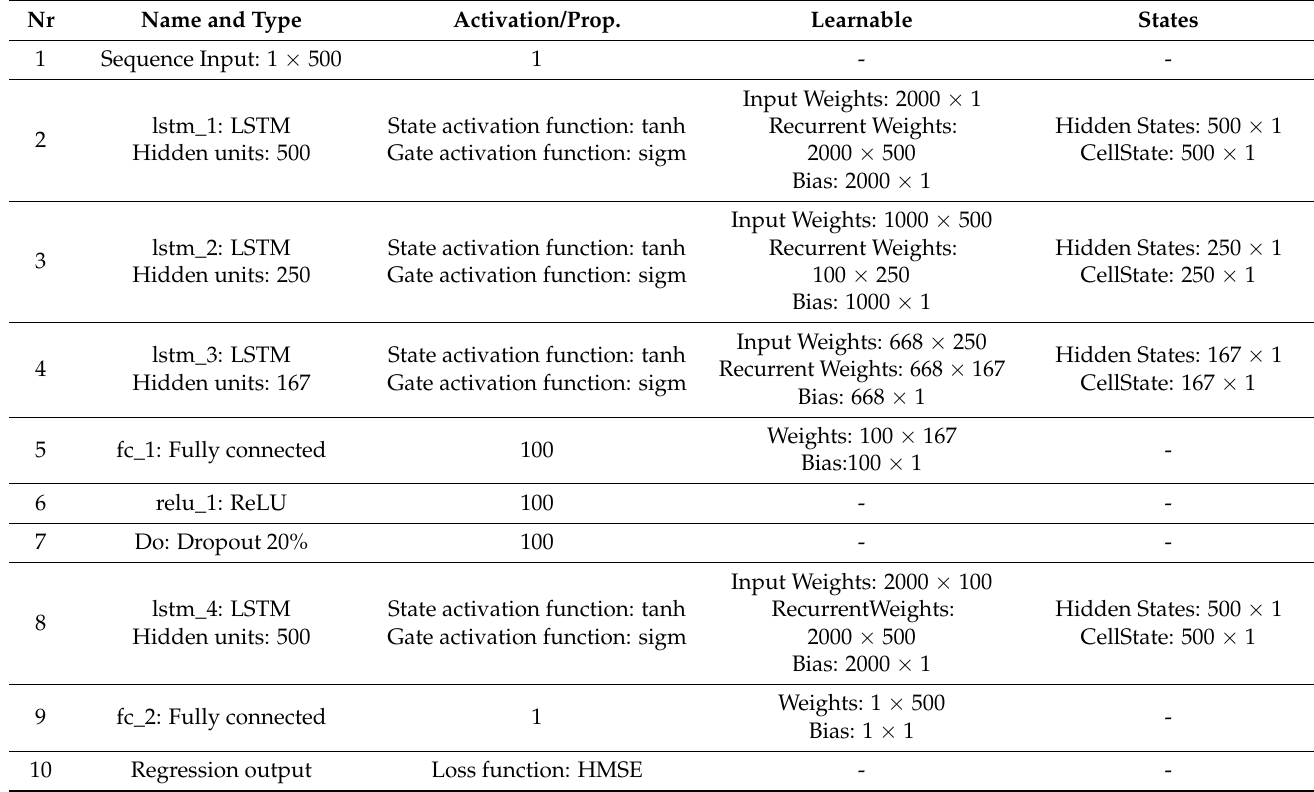
Table 2. Listing of neural network layer with sinusoidal paths: s = 500 samples per input